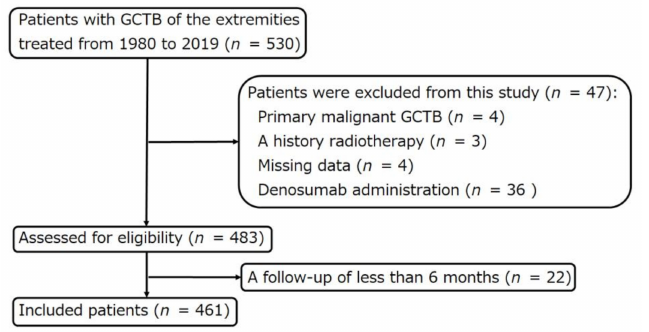
Figure 1. Flow diagram of patients with giant cell tumor of bone of the extremity treated at two institutions between 1980 and